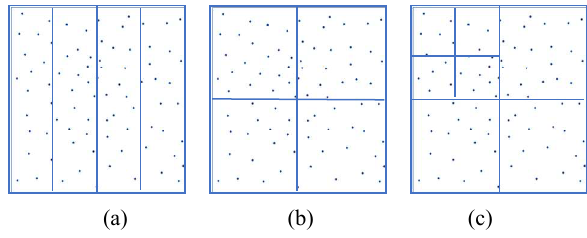
Figure 2. Possible point cloud partition strategies: